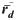
The r¯d density distribution for the OCT/Tyr receptor.The r¯d values are placed on the x-axis while the relative occurrence of each of these values is displayed on the y-axis. The observed value falls outside of the distribution range generated by the randomized data set indicating that there is gametic disequilibrium.